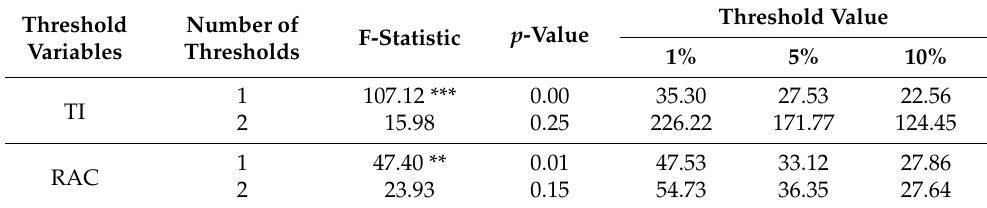
Table 11. Threshold regression test.